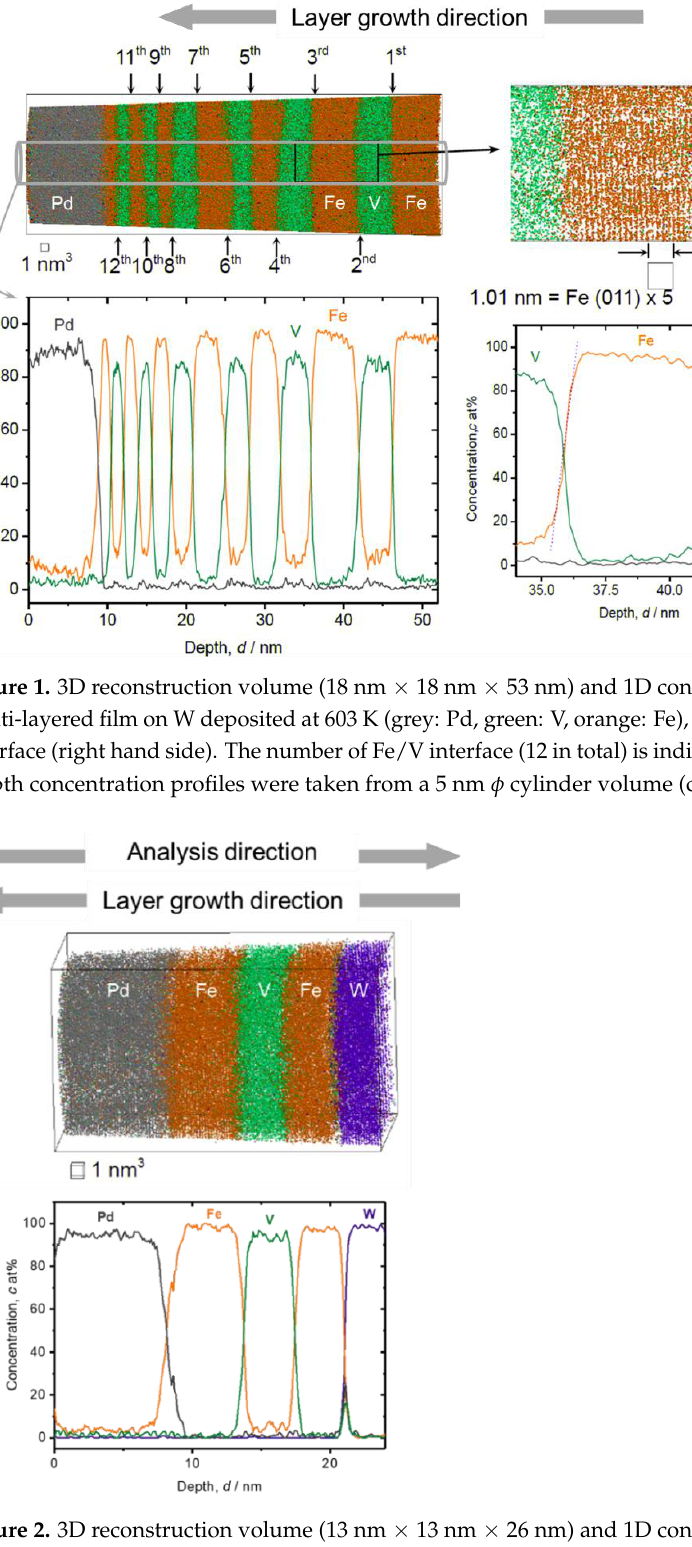
Figure 2. 3D reconstruction volume (13 nm × 13 nm × 26 nm) and 1D concentration profile of Fe/V multi-layered film deposited on W deposited at 297 K (grey: Pd, green: V, orange: Fe, blue: W). Depth concentration profile was taken from a 5 nm φ cylinder volume. The slope for deposition sequence of V on Fe is slightly steeper than that of Fe on V.